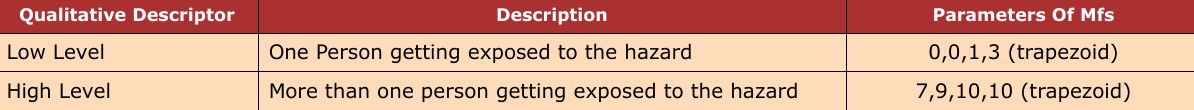
Table 4. Exposure Level (E)